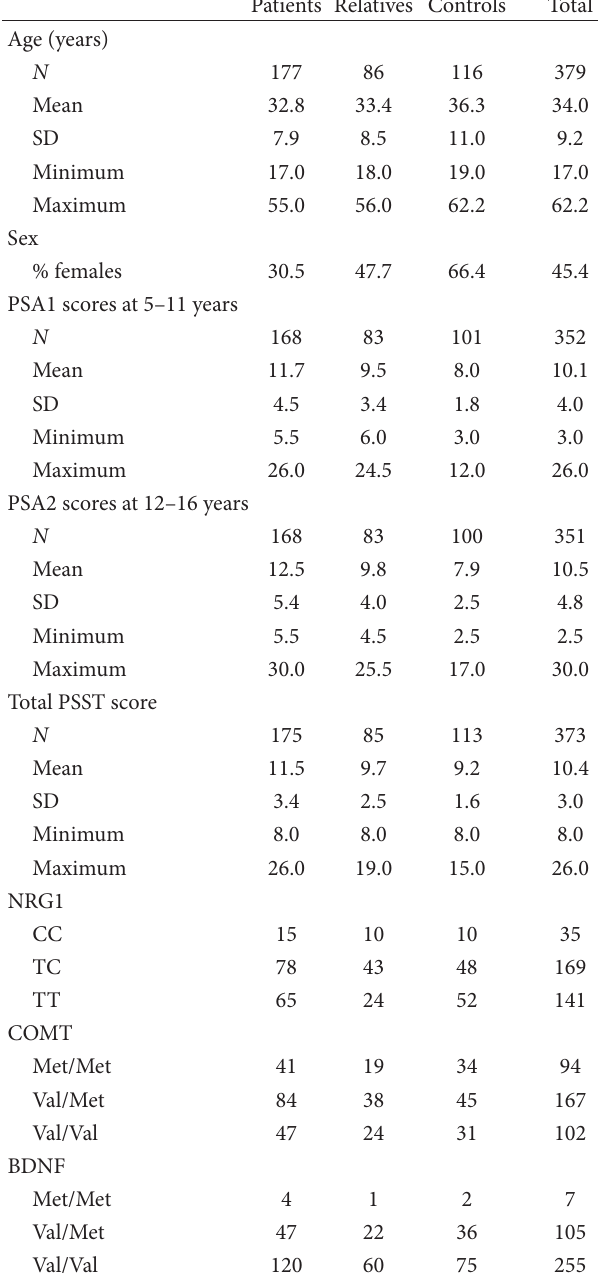
T 1: Demographics, scale scores, and genotype